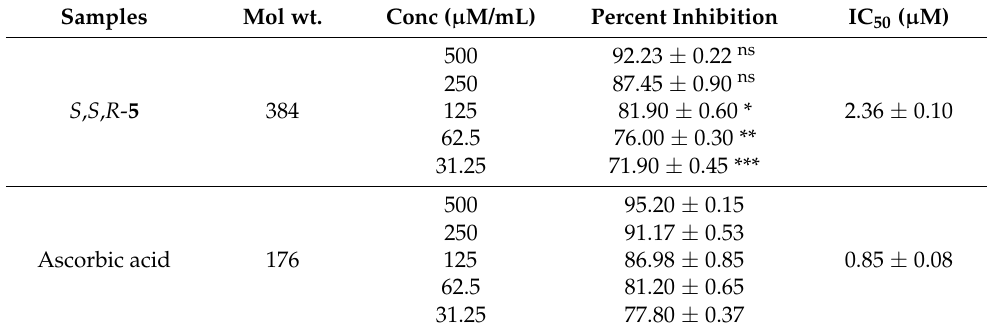
Table 5. DPPH results of S , S , R - 5 .